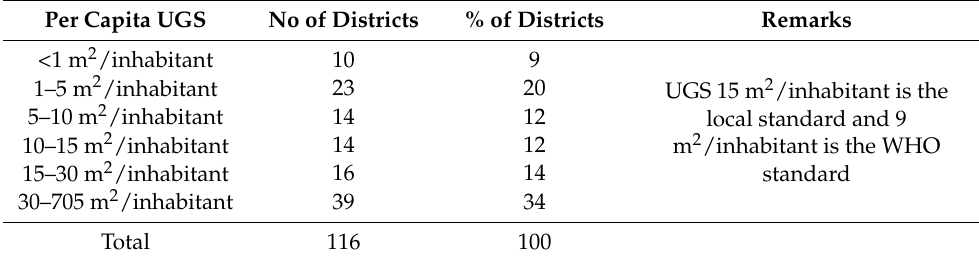
Table 5. Urban green space per capita distribution in the districts in Addis